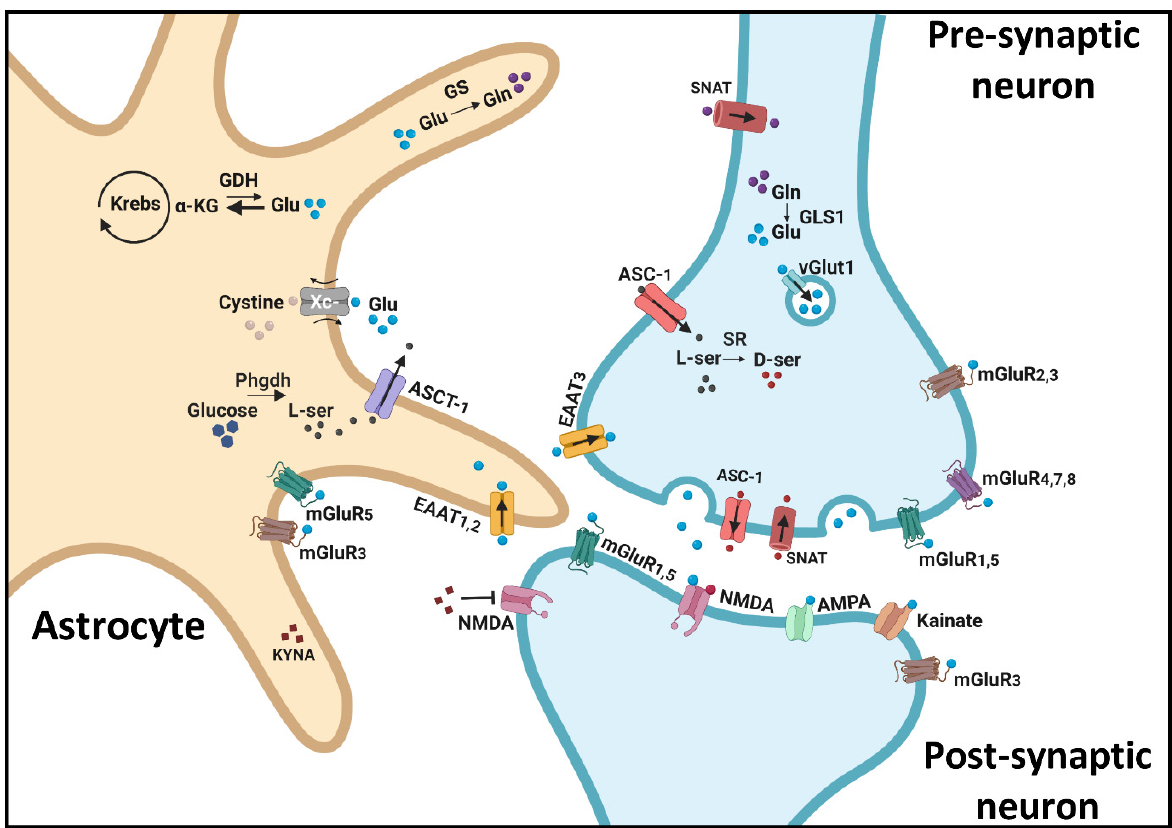
Figure 1. The glutamate tripartite synapse. Neuronal and astrocytic processes involved in controlling glutamate homeostasis. a-KG = α -ketoglutarate; AMPA = α -amino-3-hydroxy-5-methyl-4-isoxazolepropionic acid; Asc-1 = alanine–serine–cysteine transporter 1; ASCT-1 = alanine–serine–cysteine–threonine transporter 1; D-ser = D-serine; EAAT = excitatory amino acid transporters; GDH = glutamate dehydrogenase; Gln = glutamine; GLS1 = glutaminase; Glu = glutamate; GS = glutamine synthetase; KYNA = kynurenic acid; L-ser = L-serine; mGluR = metabotropic glutamate receptors; NMDA = N-methyl-D-aspartate; Phgdh = 3-phosphoglycerate dehydrogenase; SNAT = sodium-coupled neutral amino acid transporters; SR = serine racemase (also reported to be found in astrocytes and post-synaptic neurons, see text); vGluts = vesicular glutamate transporter 1; Xc- = cystine–glutamate antiporter.